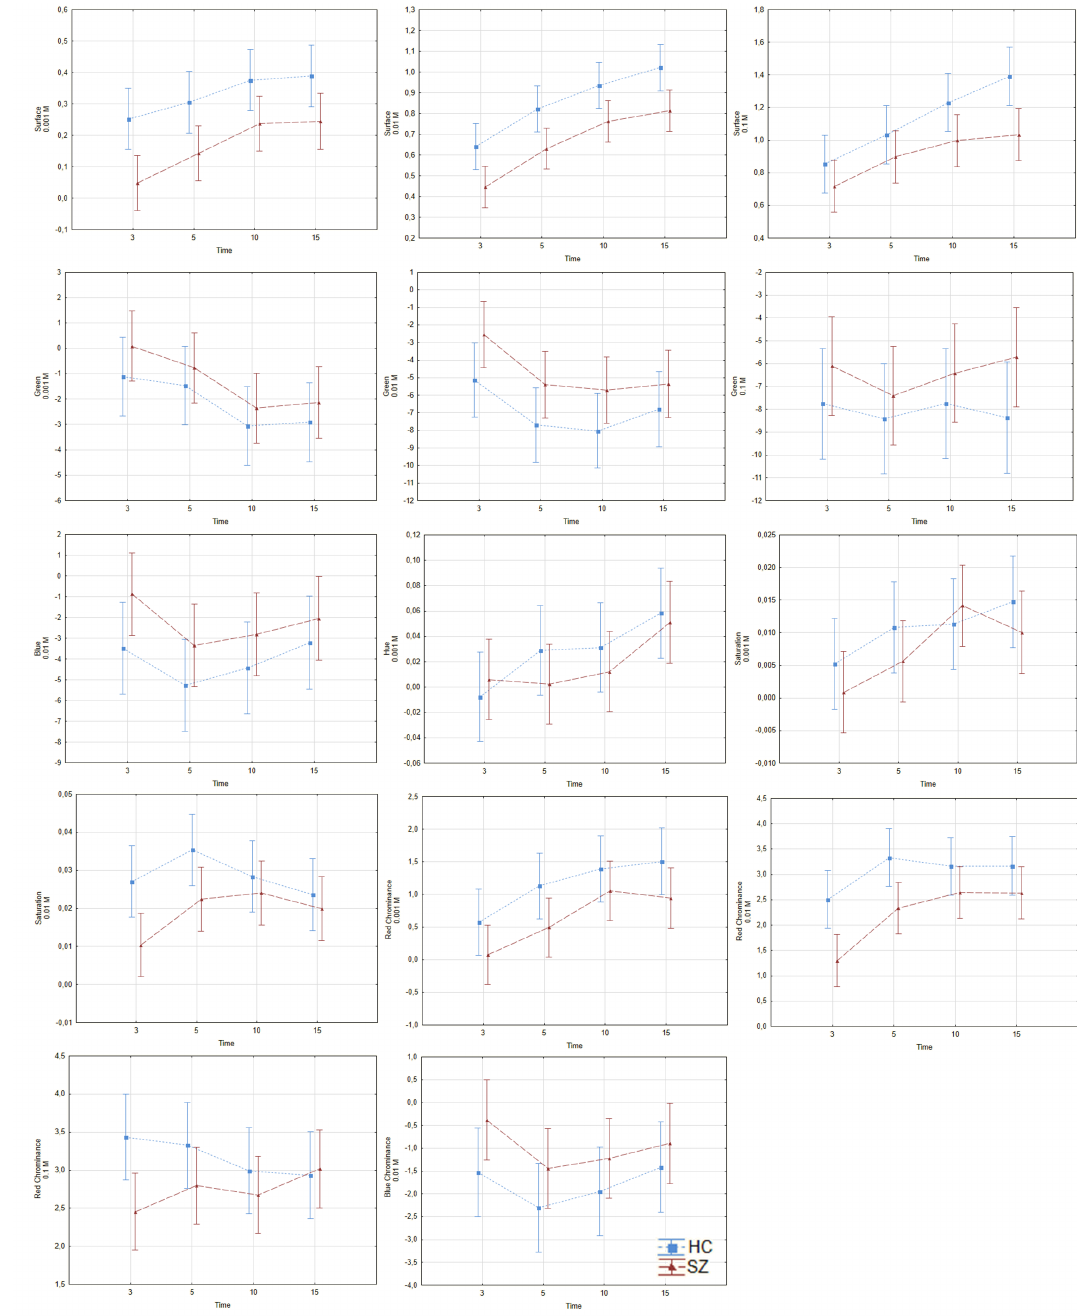
Figure 2. Di ff erences in responses to niacin solution between HC and SZ. The red line—SZ group, the blue line—HC group, the vertical axis—skin color, the horizontal axis—time of measurement in minutes. Diagrams represent group and within-subjects e ff ects described in the Section 3.1.1. SZ—schizophrenia; HC—healthy control. ( a ) surface, 0.001 M; ( b ) surface, 0.01 M; ( c ) surface, 0.1